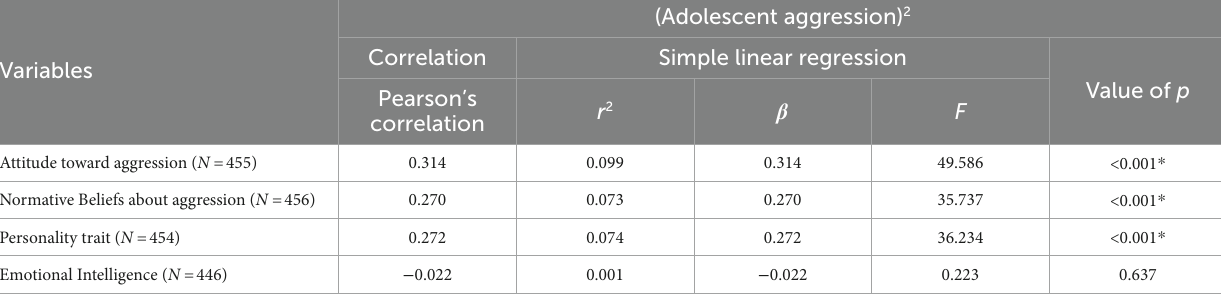
TABLE 2 Association between psychological factors and (adolescent aggression) 2 by Pearson’s correlation and simple linear